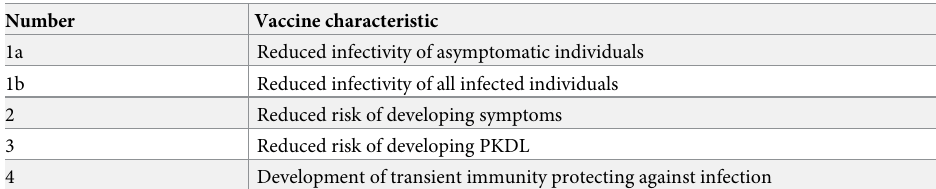
Table 1. Human VL vaccine